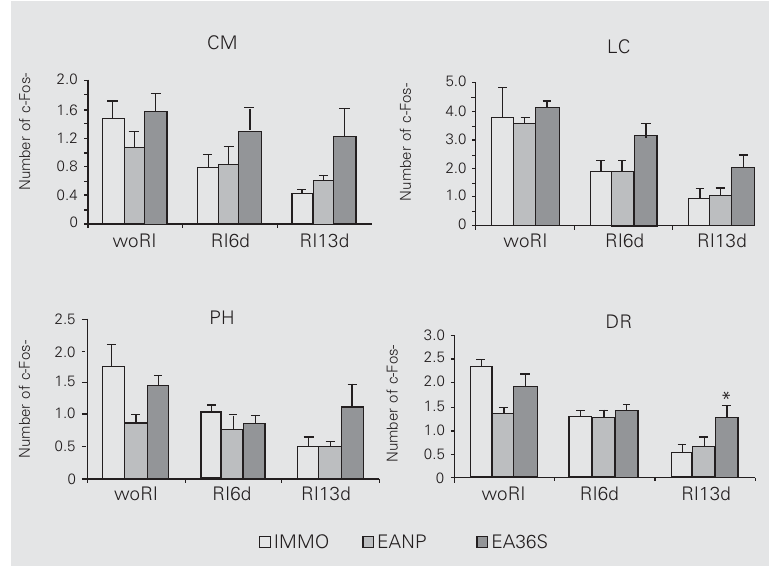
Figure 4. c-Fos expression induced by electroacupunc- ture in the central medial nucleus of the thalamus (CM), locus coeruleus (LC), posterior hypothalamus (PH) and dorsal raphe nucleus (DR) of animals previ- ously submitted to repeated immobilization. Animals were previously subjected to 6 days of repeated im- mobilization (1 h/day), group RI6d, or to 13 days of repeated immobilization (2 h/day), group RI13d, or were left undisturbed in their home cages for 6 days, group woRI. On the 7th (woRI and RI6d groups) or 14th day (RI13d group), animals were further divided into 3 sub- groups: only subjected to immobilization (IMMO), im- mobilized and submitted to EA36S, and immobilized and submitted to electroacupuncture at a non-acupoint site (EANP). *Different from RI13d-IMMO and RI13d- EANP (P < 0.05, ANOVA followed by Fisher’s post hoc